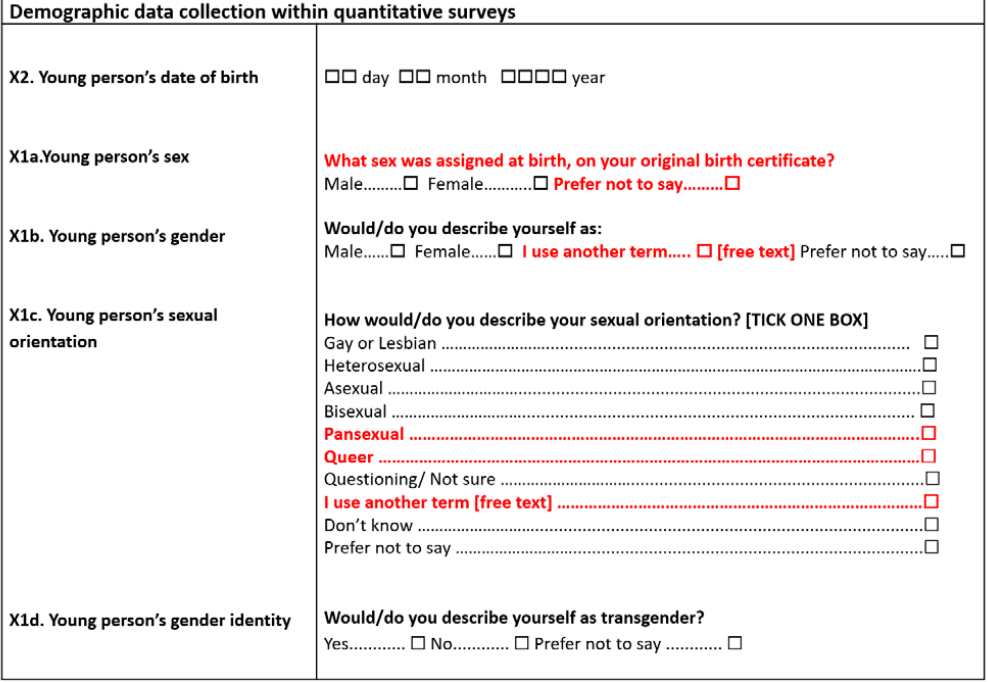
Figure 5. Suggestions for inclusion of SOGI questions in demographic data collection within quantitative surveys.